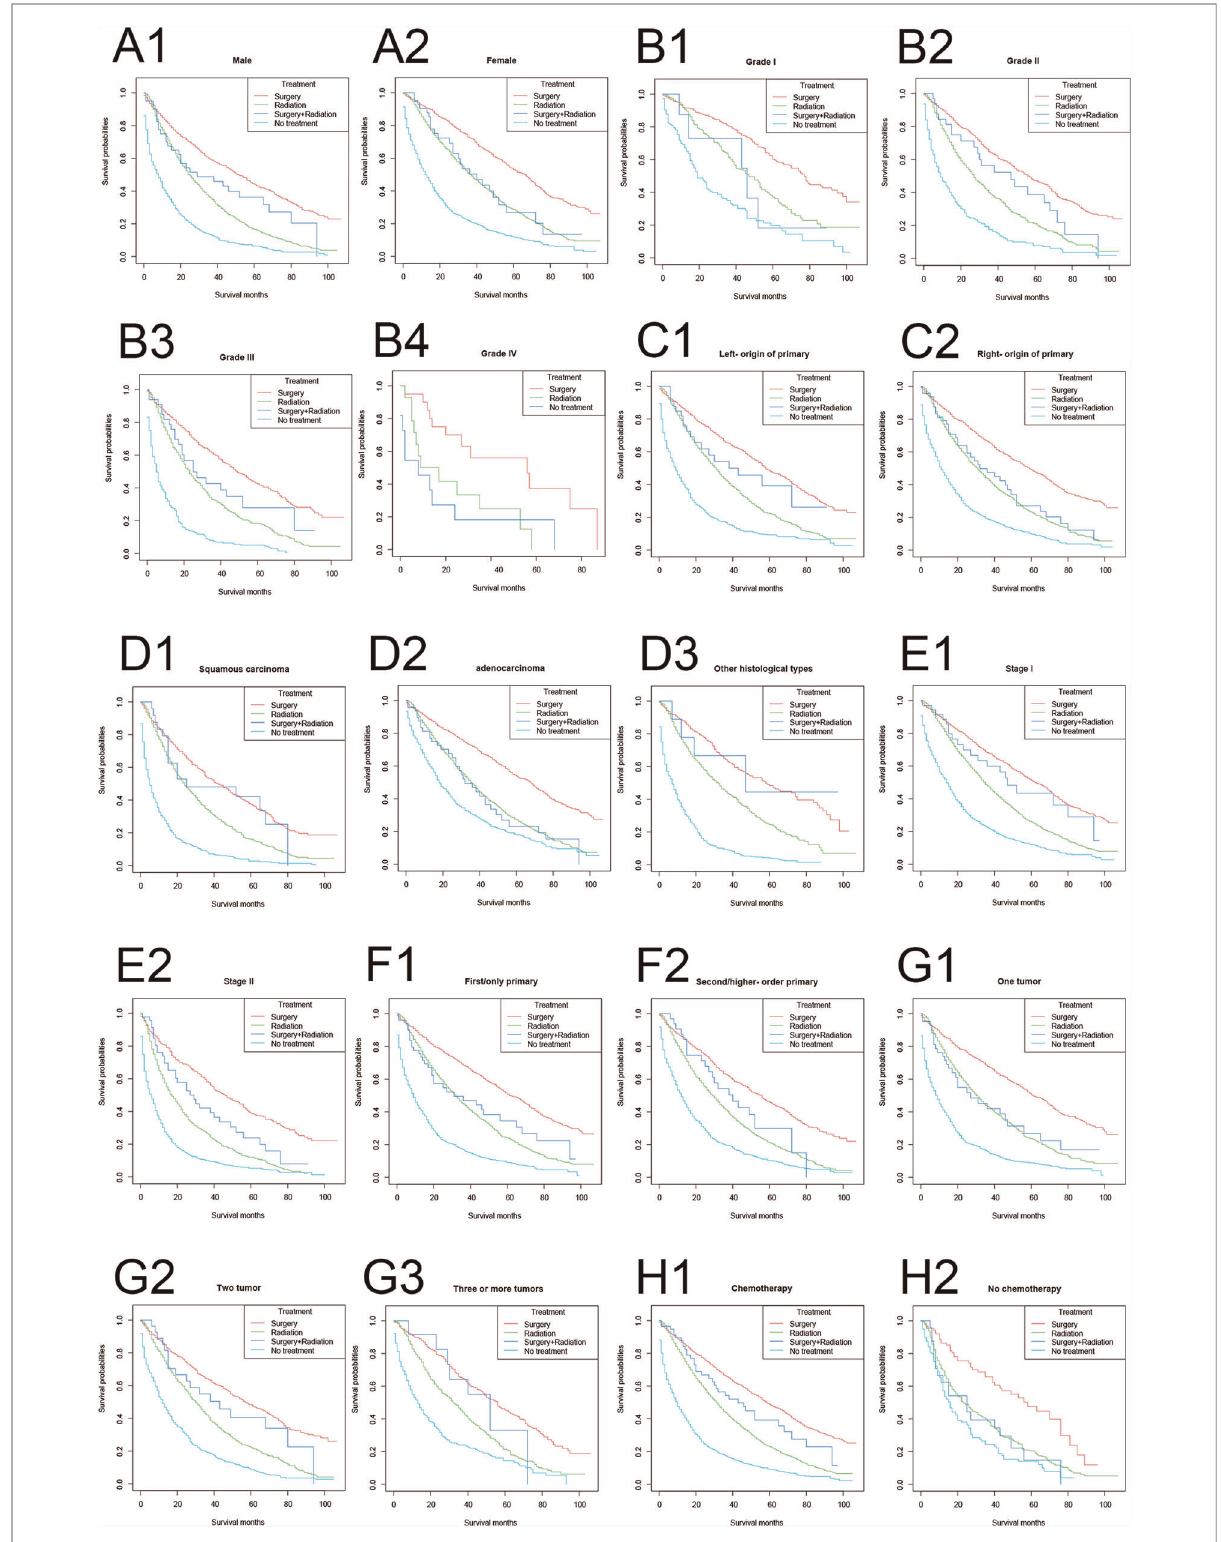
FIGURE 3 Overall survival strati fi ed by treatment modalities among patients ≥ 80 years old with NSCLC in different strati fi cations. (A1 – A2) Strati fi ed by sex; (B1 – B4) strati fi ed by grade; (C1 – C2) strati fi ed by laterality; (D1 – D3) strati fi ed by histology; (E1 – E2) strati fi ed by stage; (F1 – F2) strati fi ed by sequence number; (G1 – G3) strati fi ed by number of tumors; (H1 – H2) strati fi ed by